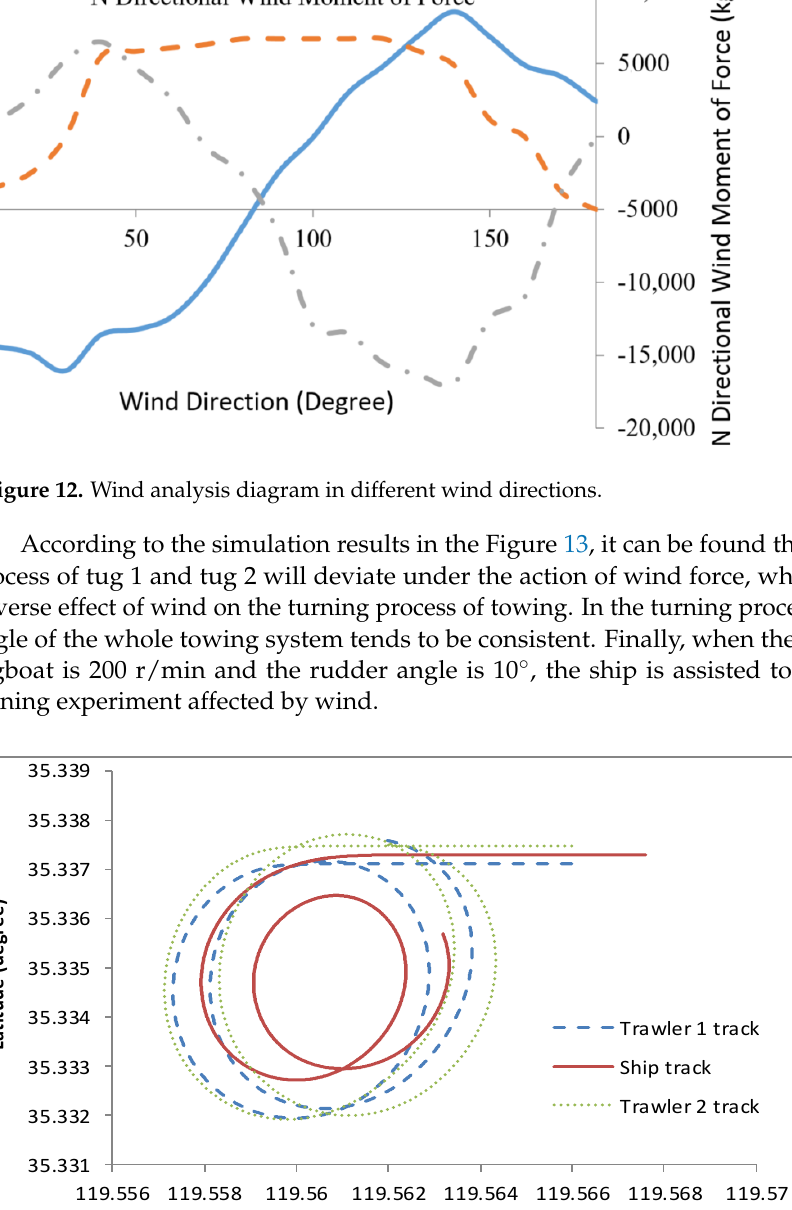
Figure 11. Radar chart of wind direction coefficient. ( a ) Coefficient 𝐴 𝑖 , ( b ) coefficient 𝐵 𝑖 , and ( c ) coefficient 𝐶 𝑖 .